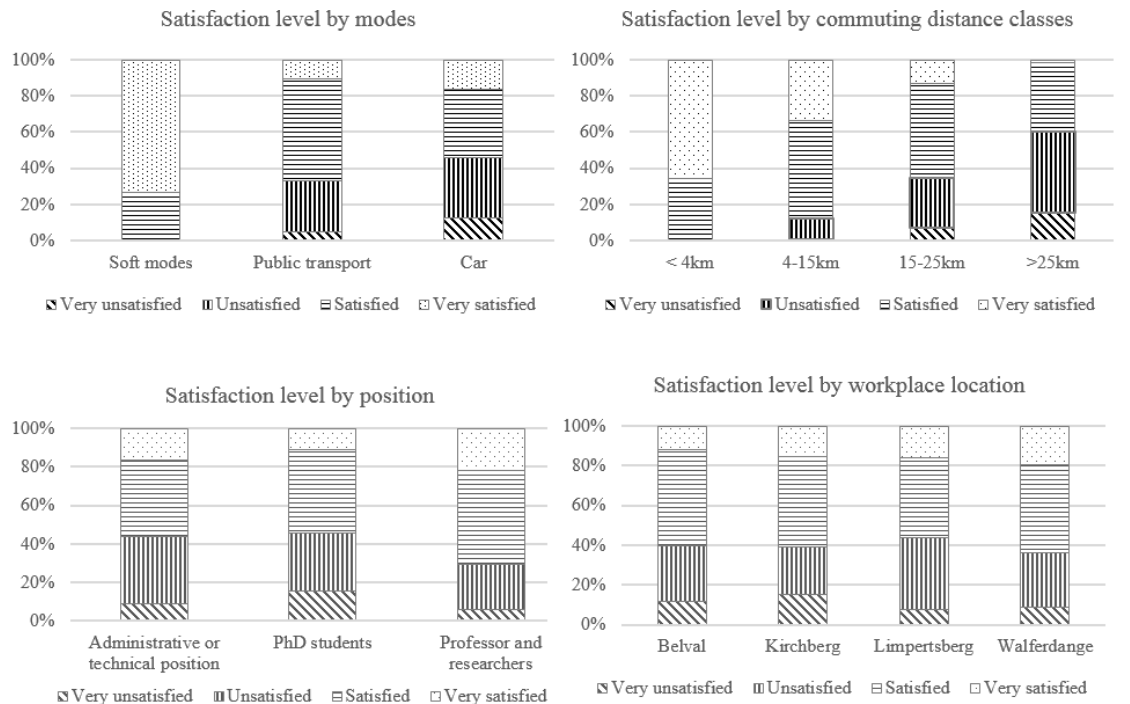
Figure 1. Satisfaction